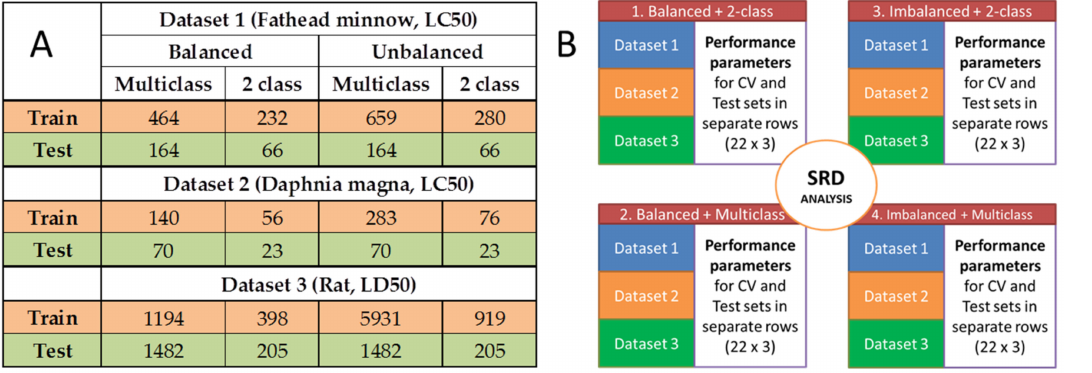
Figure 2. ( A ) Summary of the number of molecules for the three datasets with specific conditions. ( B ) Illustration of merged datasets for the SRD analyses. Datasets 1, 2 and 3 contain the performance parameters of the calculated models. (CV is short for cross-validation.)